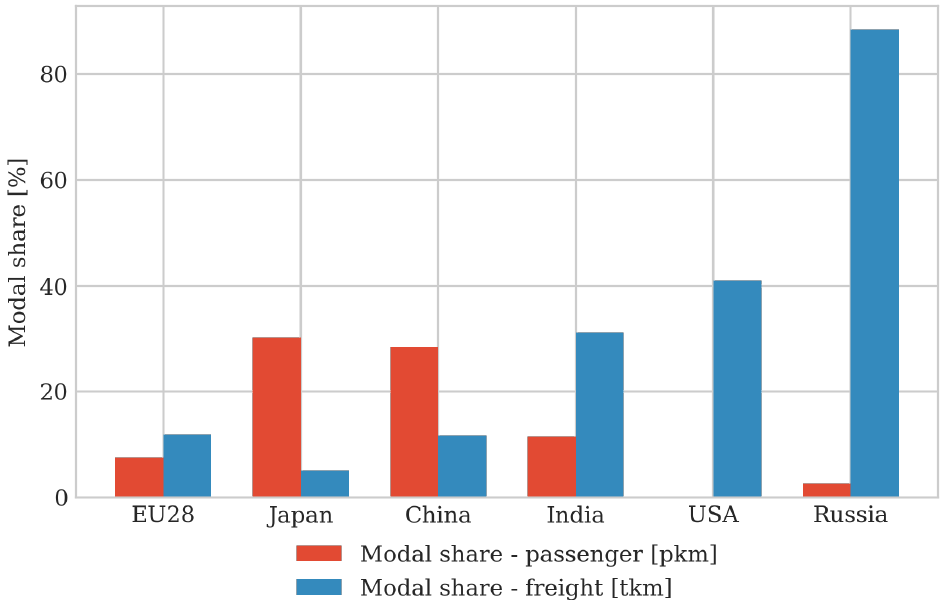
Figure 2. Modal share of rail in selected regions in 2015. Own study based on data from [47].